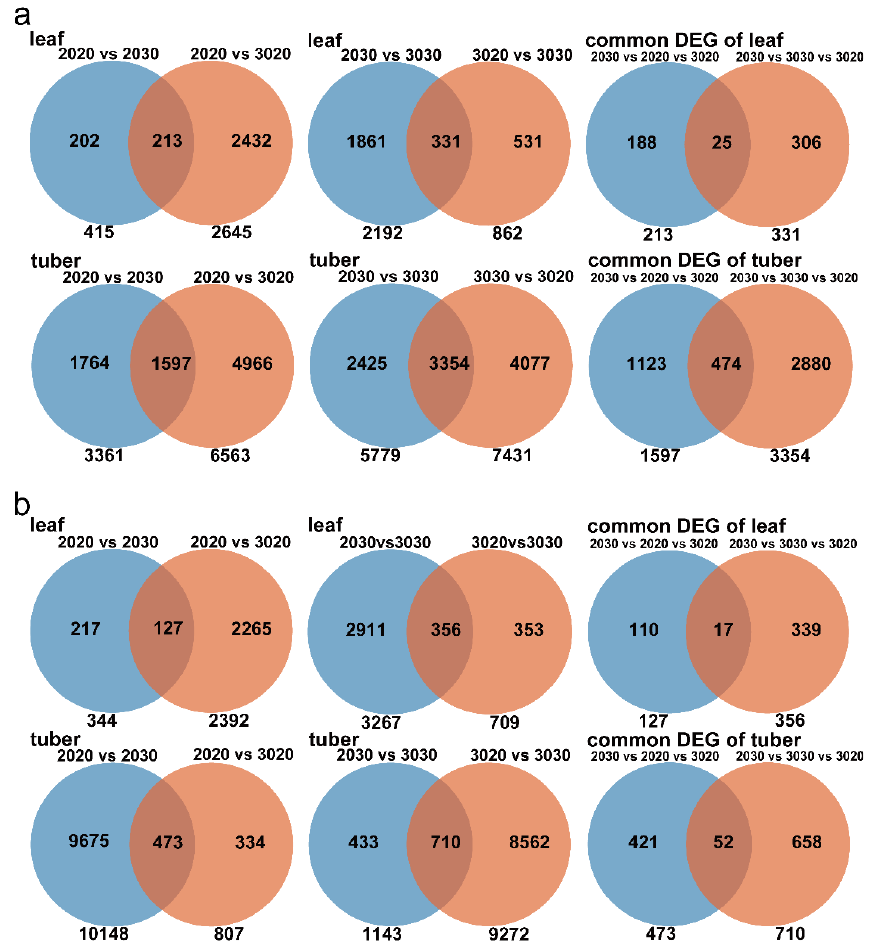
Figure 6. A Venn diagram showing the number of DEGs of the Qs9 ( a ) and D187 ( b ) plants under the heat-stress treatment of different plant parts. Genes with a log2-fold change greater than 1.5-fold and a p -value < 0.01 were considered DEGs.